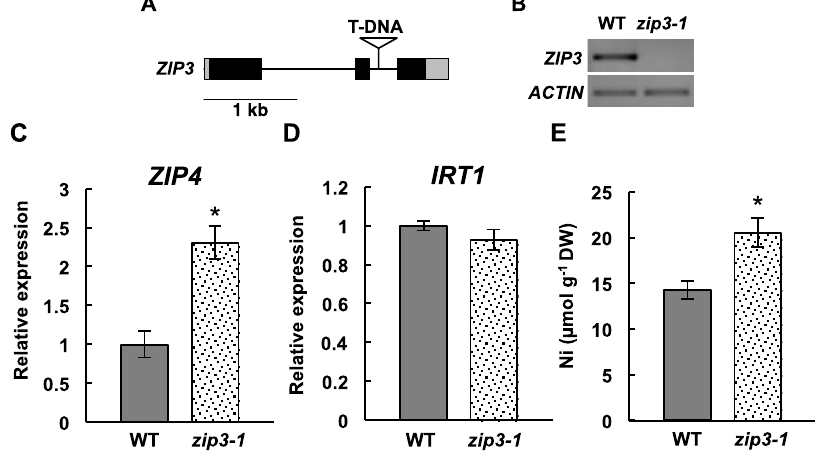
Figure 3. Ni accumulation in the Zrt/Irt-like protein 3 ( ZIP3 ) mutant. ( A ) Scheme showing the T-DNA insertion site in zip3-1 ; ( B ) Semi-quantitative amplification of